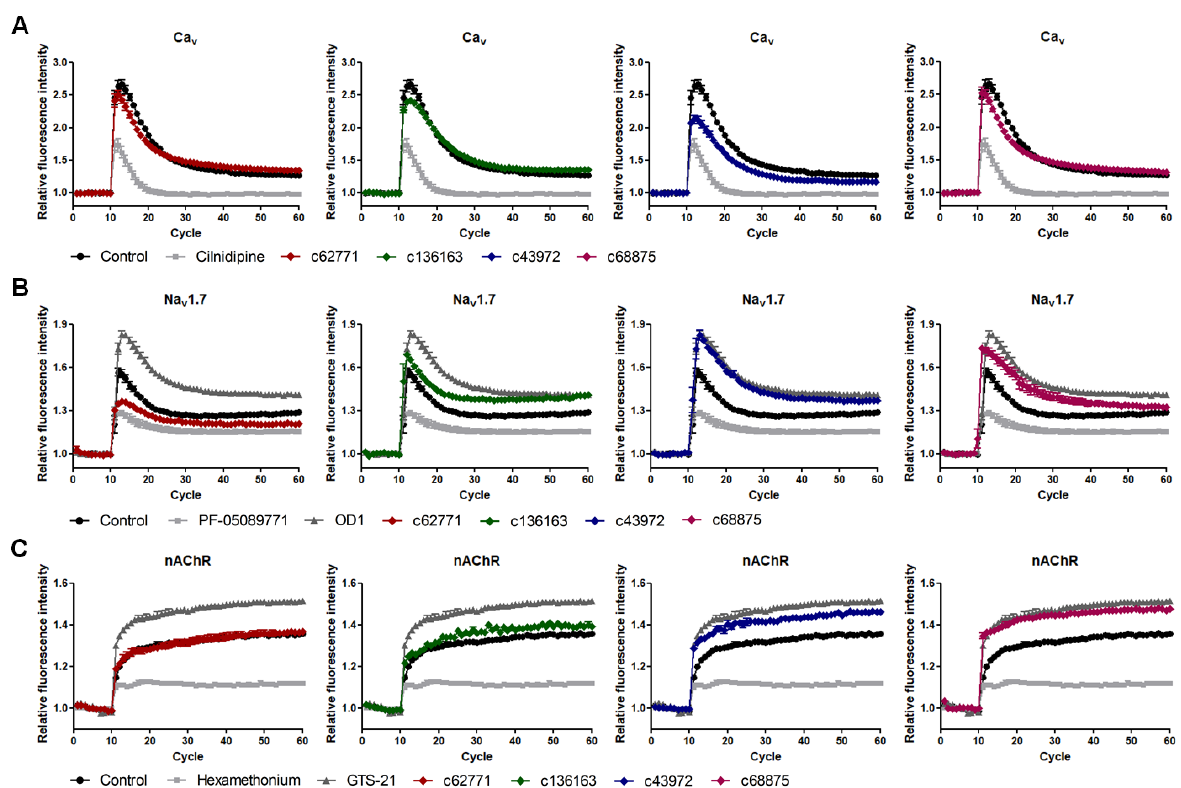
Figure 4. Modulatory effects of predicted peptides on the ion channel activity. Each of the four peptides from the AUG model prediction showed either activation or inhibition on specific ion channel subtype. Peptides were treated with the final concentration of 10 µ M. ( A ) Peptide c43972 had an inhibitory effect on Ca v when compared with the L-/N-type calcium channel inhibitor cilnidipine. ( B ) Peptide c62771 reduced the activity of Na v 1.7 channels, whereas c136163, c43972, and c68875 activated the channel. ( C ) The nAchR were activated when treated with c43972 and c68875.